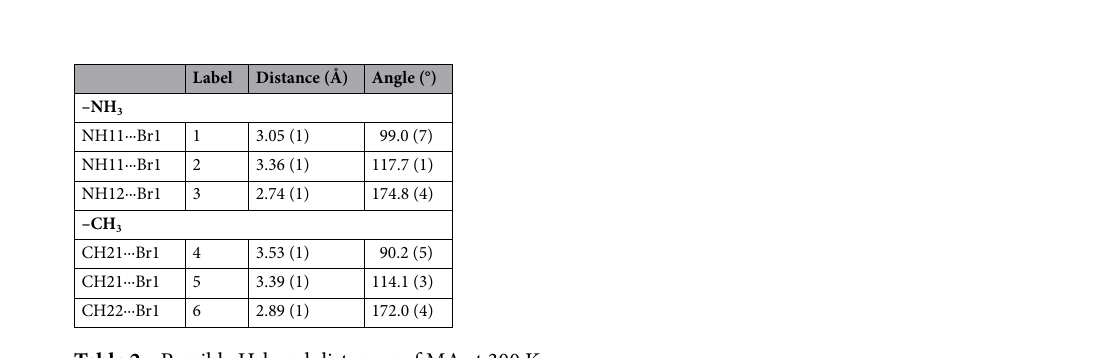
Table 2. Possible H-bond distances of MA at 300 K.